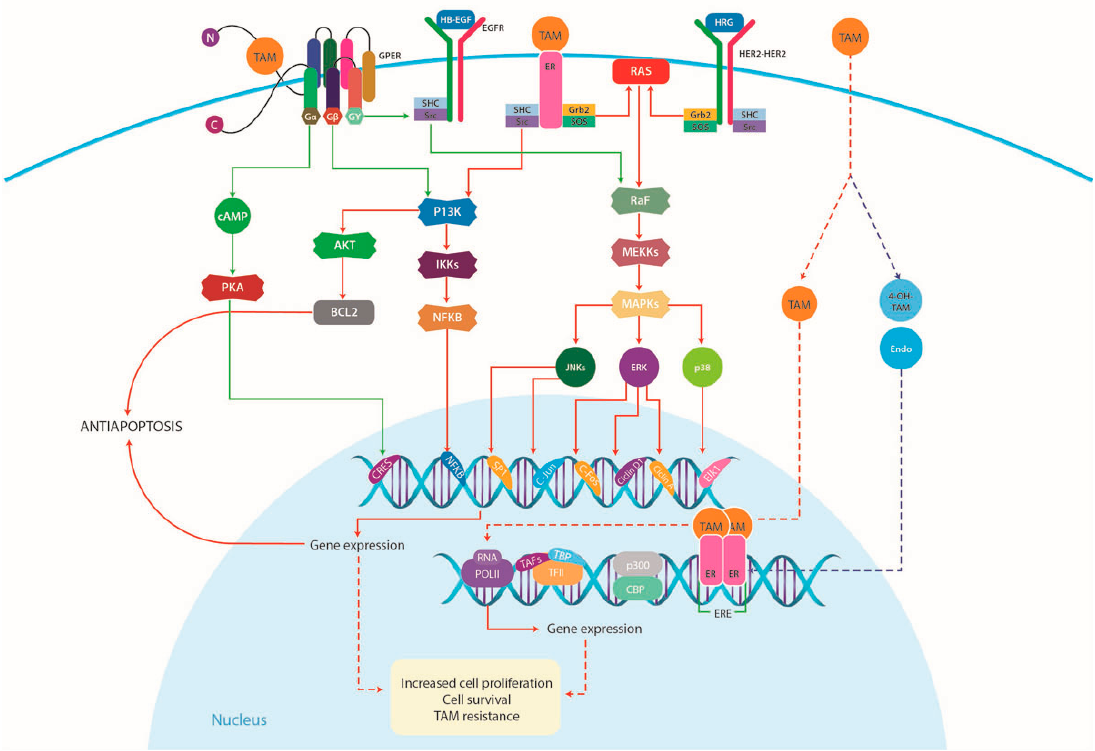
Figure 5. Proposed model of cell proliferation mediated by TAM in breast cancer cells. TAM can activate both GPER and membrane-associated ERs and crosstalk with growth factor signaling pathways, including HER2 and EGFR receptors, in a manner analogous to E2. TAM resistance can therefore be attributed, at least partly, to the GPER receptor, suggesting a role for GPER in non-classical steroid hormone actions. In fact, TAM as well as its metabolite, 4-OH-TAM, have high-affinity binding to GPER and mimic the rapid, non-genomic E2 effects in breast cancer cells. EGFR, epidermal growth factor receptor; ER, estrogen receptor; GPER, G-protein coupled estrogen receptor; HB-EGF, heparin-binding epidermal growth factor; HRG, heregulins; Src, cytoplasmic tyrosine kinase; MAPK, mitogen-activated protein kinases; PI3K/Akt, phosphatidylinositol 3-kinase/protein kinase B; PKC, protein kinase C; cAMP, cyclic AMP. Modified from SABiosciences (http://www.sabiosciences.com/pathway.php?sn=Estrogen_Pathway).